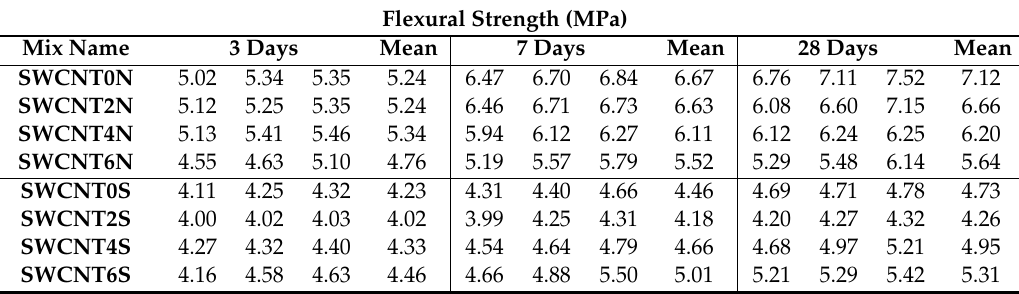
Table 12. Flexural strength test results of SWCNT-added specimens